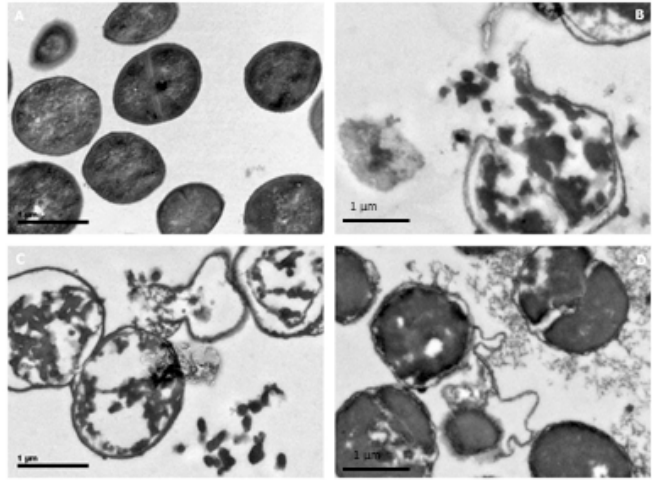
Figure 9. Electron microscopy micrographs (40 × ) analysis of S. carnosus nonincubated and incubated with modified hen egg white lysozyme (HEWL) (0.5 mg/mL): ( A ) Bacteria control without HEWL, ( B ) HEWL/90 °C at pH 6.0, ( C ) HEWL/120 °C at pH 6.0, and ( D ) HEWL/DTT 2.0 h.